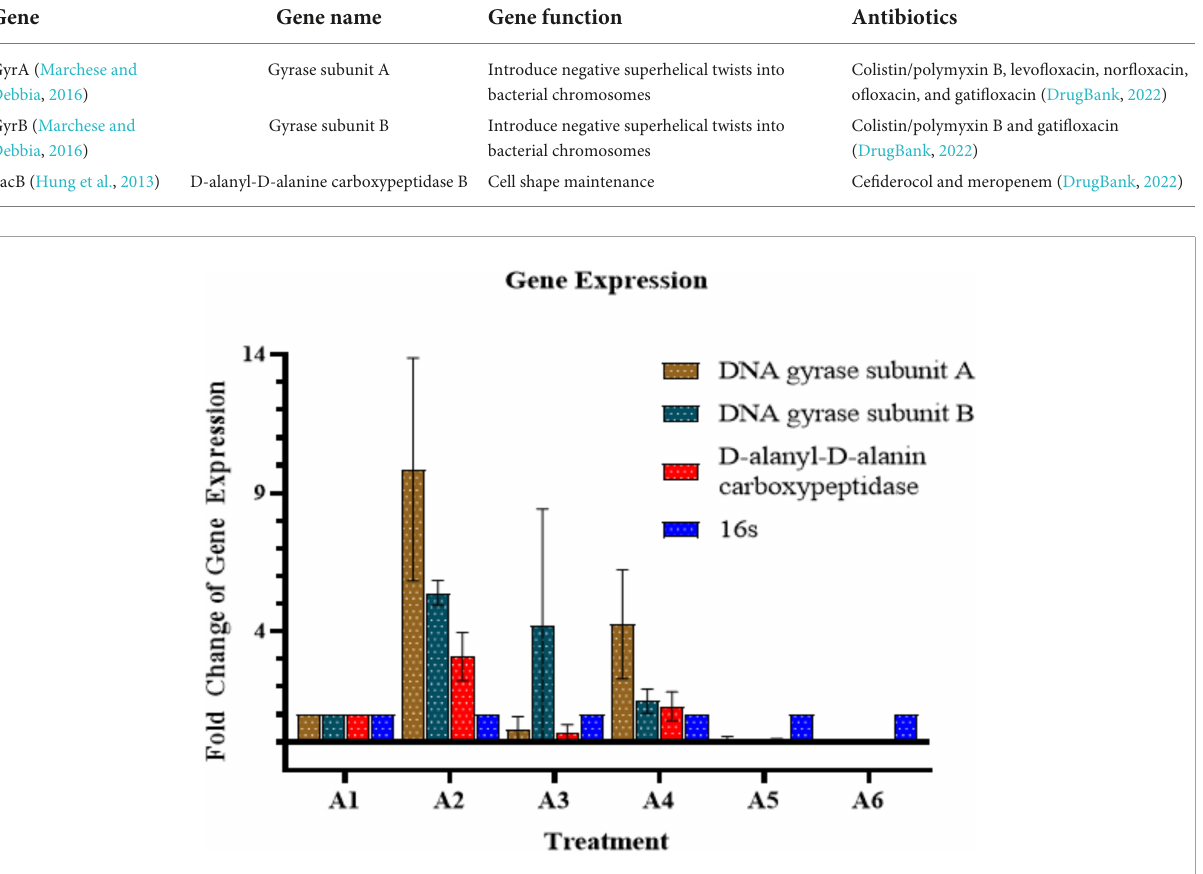
FIGURE5 Quantitative Real-time PCR (qRT–PCR) analysis: The graph shows gene expression of GyrA, GyrB, and dacB (presented in y -axis) upon different treatments (presented in x -axis). Here, A1: Acinetobacter baumannii control A–C, A2: Colistin control (CC), A3: Nano-formulation control [AD-L@Ag(0)] (NF–C), A4: 1 / 2 MIC col + 1 / 4 MIC AD − L@Ag ( 0 ) , A5: 1 / 4 MIC col + 1 / 2 MIC AD − L@Ag ( 0 ) , and A6: 1 / 4 MIC col + MIC AD − L@Ag ( 0 ) . A decrease in gene expression when colistin and AD-L@Ag(0) were used in combination was observed in comparison to when only colistin was